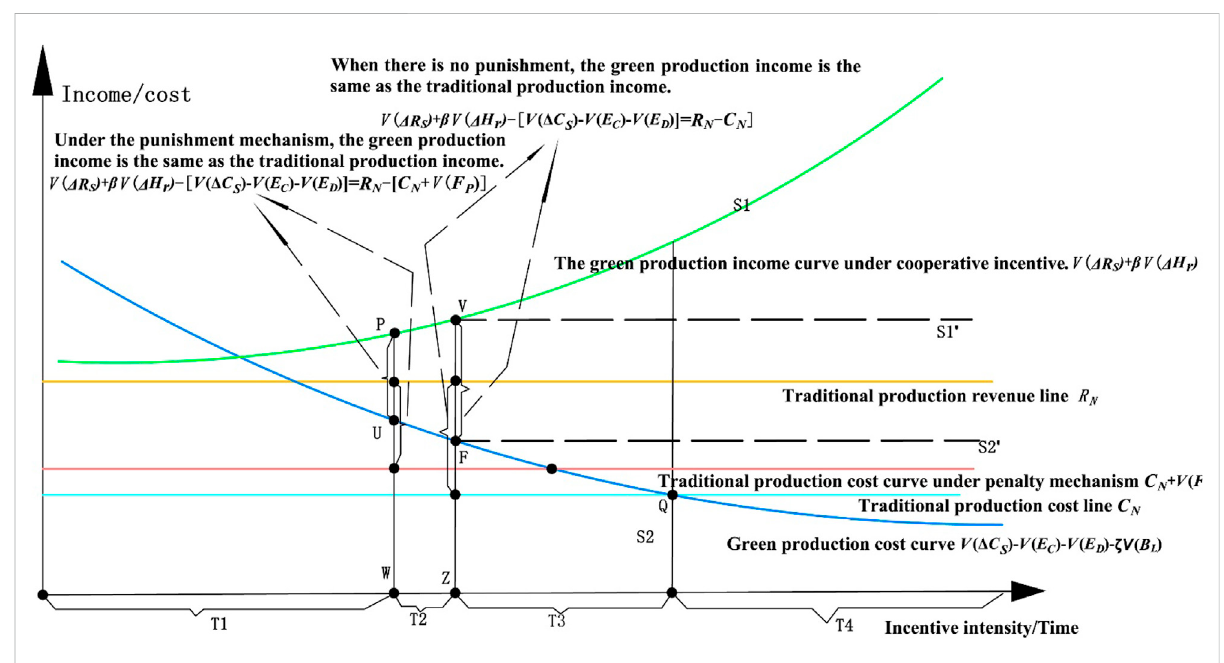
FIGURE 2 Dynamic adjustment model of incentive intensity and supervision